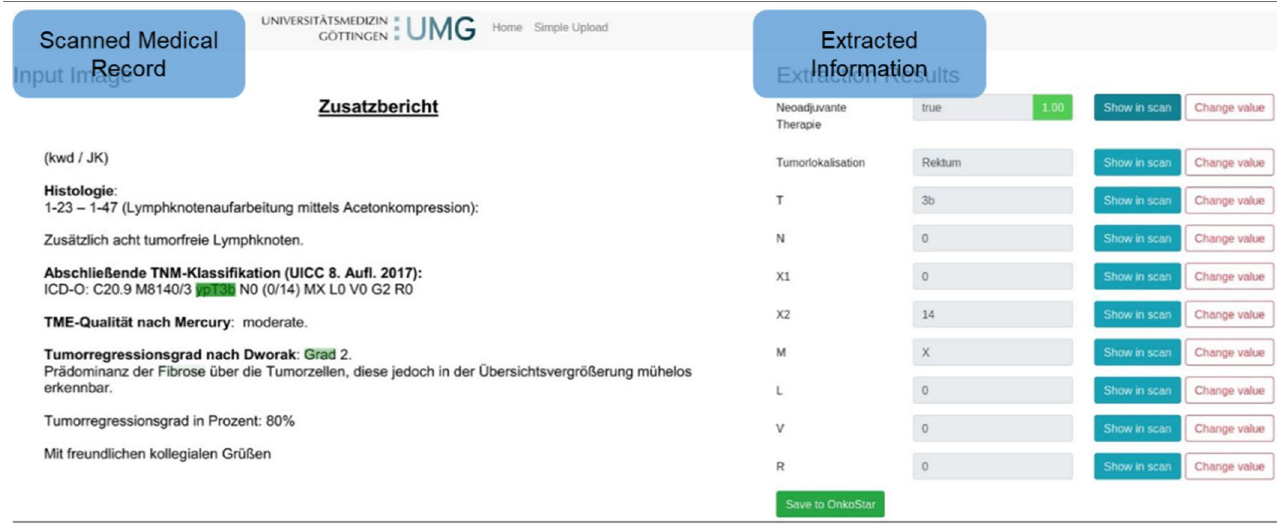
Figure 5. Screenshot of the user interface (left: scanned pathological finding; right: extraction of TNM and ICD codes).